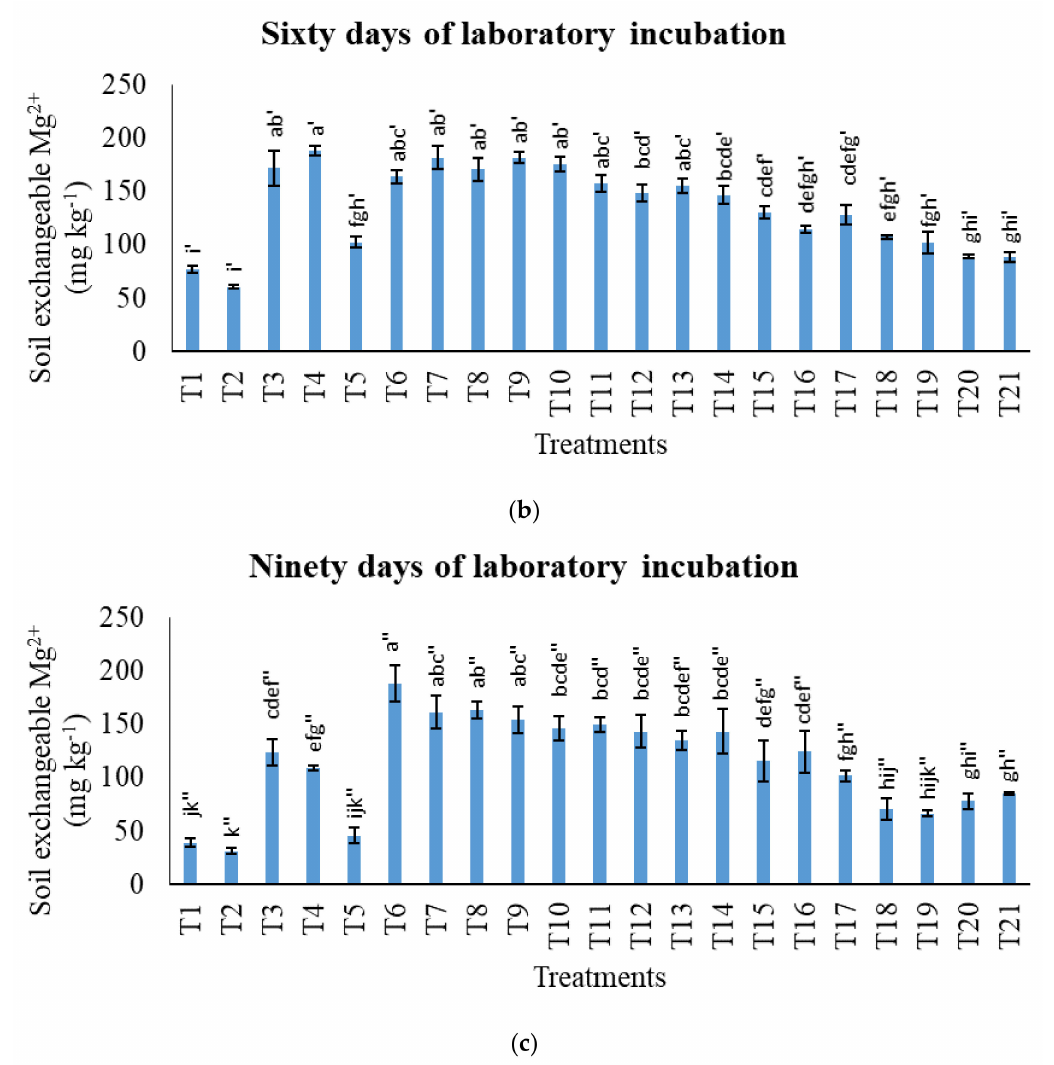
Figure 8. Effects of treatments on soil-exchangeable magnesium over ( a ) thirty; ( b ) sixty; and ( c ) ninety days after incubation. T1: soil control, T2: conventional practice, T3: muriate of potash + 100% charcoal + 100% sago bark ash, T4: muriate of potash + 100% sago bark ash, T5: muriate of potash + 100% charcoal, T6: muriate of potash + 80% charcoal + 80% sago bark ash, T7: muriate of potash + 60% charcoal + 80% sago bark ash, T8: muriate of potash + 40% + 80% sago bark ash, T9: muriate of potash + 20% charcoal + 80% sago bark ash, T10: muriate of potash + 80 charcoal + 60% sago bark ash, T11: muriate of potash + 60% charcoal + 60% sago bark ash, T12: muriate of potash + 40% charcoal + 60% sago bark ash, T13: muriate of potash + 20% charcoal + 60% sago bark ash, T14: muriate of potash + 80% charcoal + 40% sago bark ash, T15: muriate of potash + 60% charcoal + 40% sago bark ash, T16: muriate of potash + 40% charcoal + 40% sago bark ash, T17: muriate of potash + 20% charcoal + 40% sago bark ash, T18: muriate of potash + 80% charcoal + 20% sago bark ash, T19: muriate of potash + 60% charcoal + 20% sago bark ash, T20: muriate of potash + 40% charcoal + 20% sago bark ash, and T21: muriate of potash + 20% charcoal + 20% sago bark ash. Different letters indicate significant differences between means using Tukey’s HSD test at p ≤ 0.05. The error bars are the ± standard error of triplicates. Letters without any marks and letters with ‘ and ” indicate mean comparison within thirty, sixty, and ninety days after incubation,